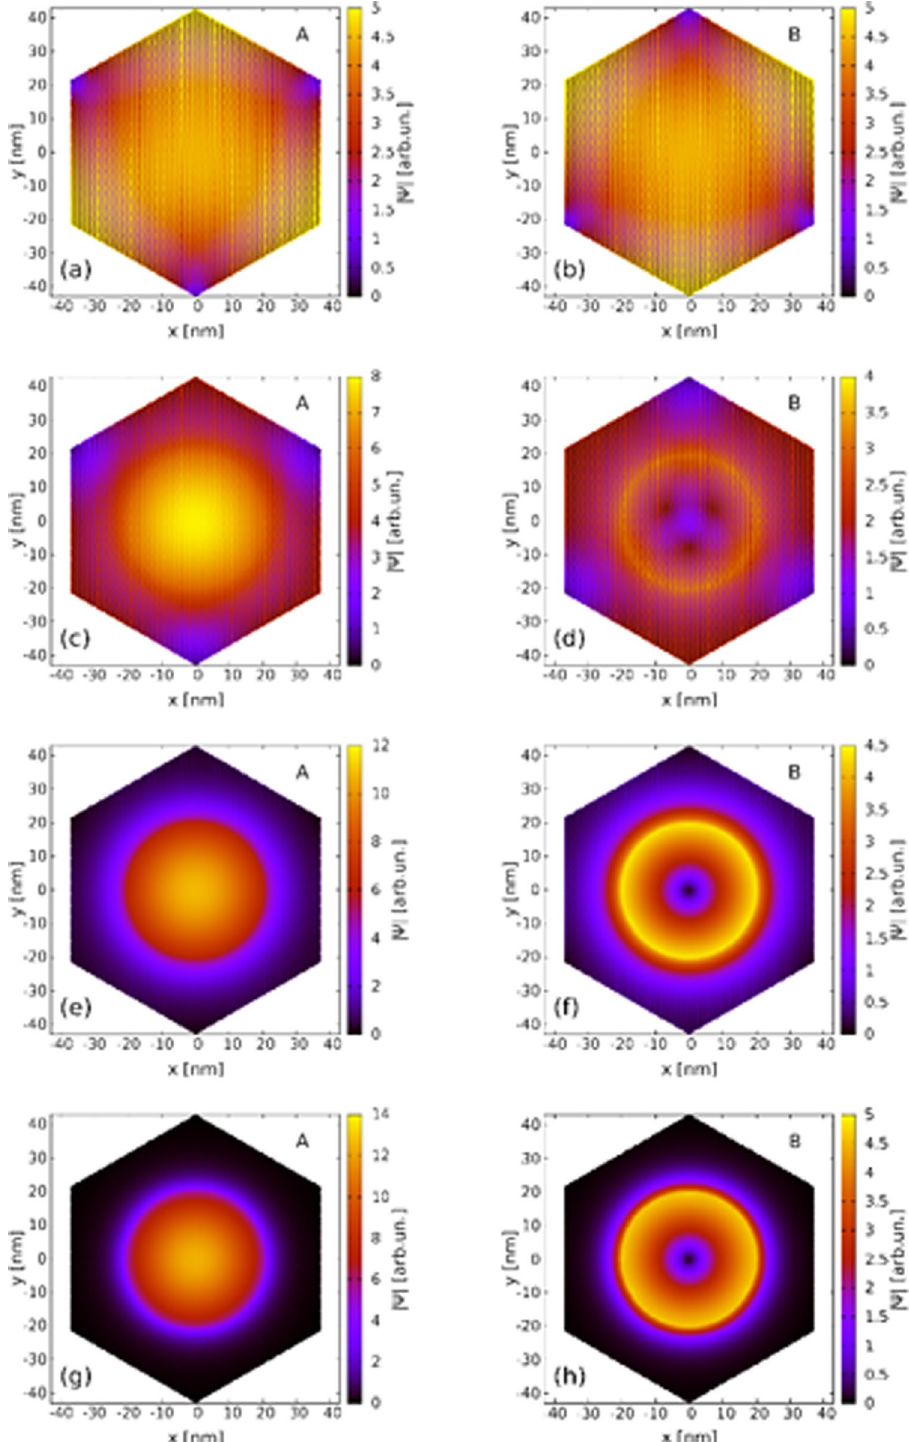
Figure 4. The absolute value of the tight-binding wave function at A (left column) and B (right column) for the lowest conduction band energy level at B = 0.5 T for V g = 0 ( a , b ), V g = 1.875 V ( c , d ), V g = 5 V ( e , f ) and V g = 10 V ( g , h ). The results are obtained for a hexagonal armchair flake of side length 43 nm. In the continuum approach the localized ground-state is a K ′ valley j ′ = − 1/2 state with orbital angular momentum 0 and − 1 for the A and B sublattice components,